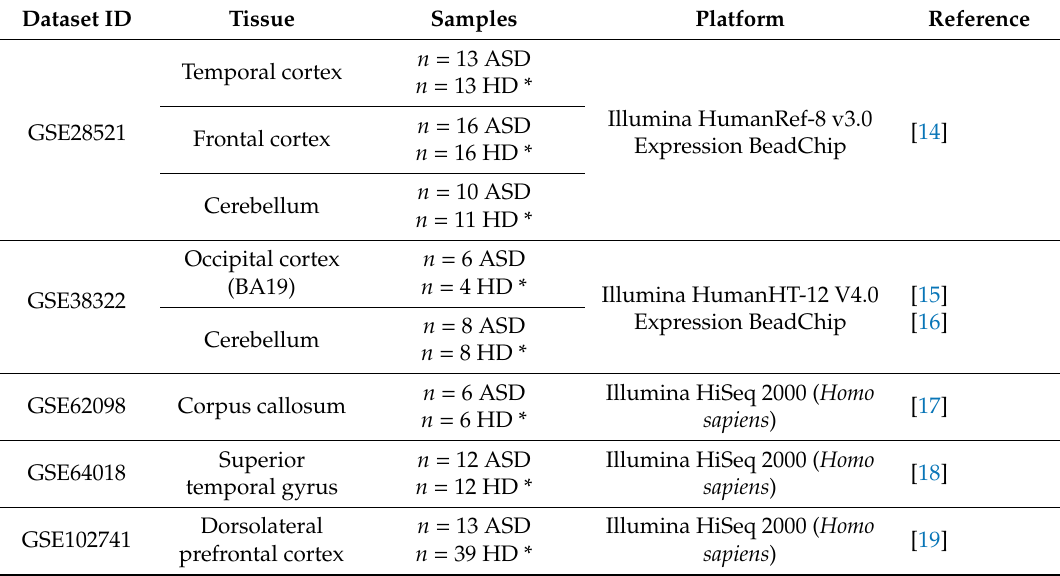
Table 1. Characteristics of the datasets used in the